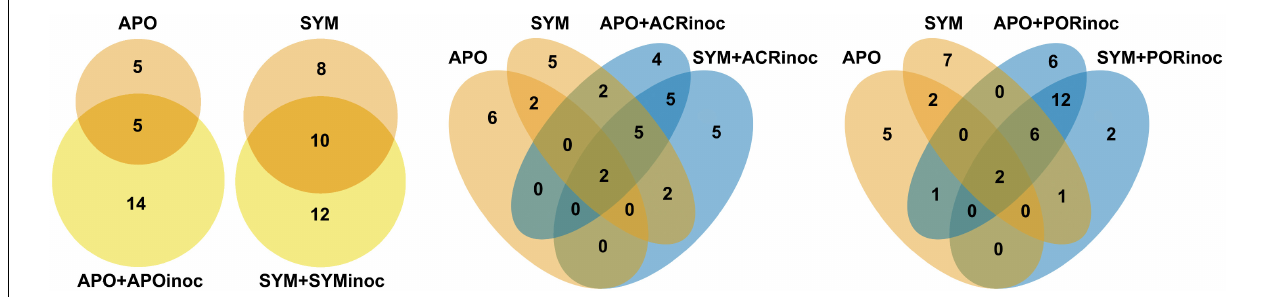
FIGURE 5 | Bacterial taxa of control and microbiome transplanted Aiptasia. Venn diagrams representing the number of active OTUs ubiquitously present in all control anemones (APO/SYM), shared between APO/SYM anemones and transplanted anemones (APO+APOinoc, APO+ACRinoc, APO+PORinoc and SYM+SYMinoc, SYM+ACRinoc, SYM+PORinoc), and ubiquitously present in transplanted anemones 7 days after the microbiome transplantation. In the absence of sequenced inocula we chose to assess bacterial taxa that were consistently present in coral inoculated Aiptasia, but not present in control Aiptasia, as an indication for bacteria of coral origin. APO/SYM, apo- and symbiotic control anemones; APO_AB/SYM_AB, 7-day antibiotic-treated anemones with a subsequent 1-day recovery; APO+APOinoc, APO microbiome transplantation after antibiotic treatment; SYM+SYMinoc, SYM microbiome transplantation after antibiotic treatment; APO/SYM+ACRinoc, Acropora humilis microbiome transplantation after antibiotic treatment (7 days after inoculation); APO/SYM+PORinoc, Porites sp. microbiome transplantation after antibiotic treatment (7 days after